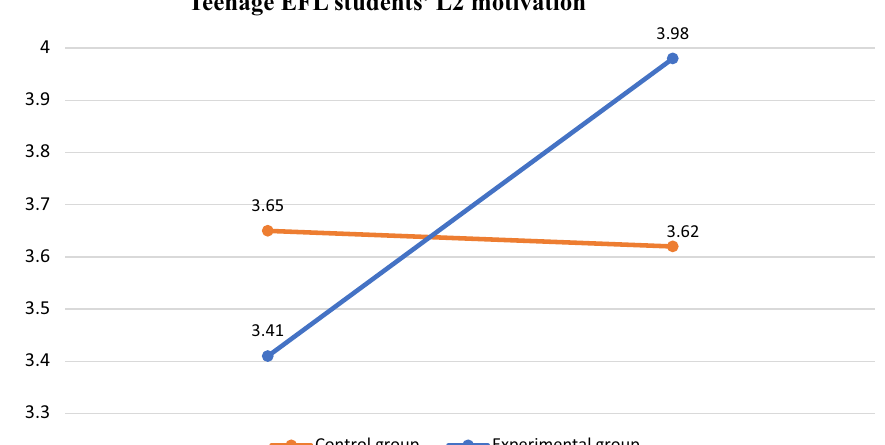
Fig. 1 Teenage EFL students’ L2